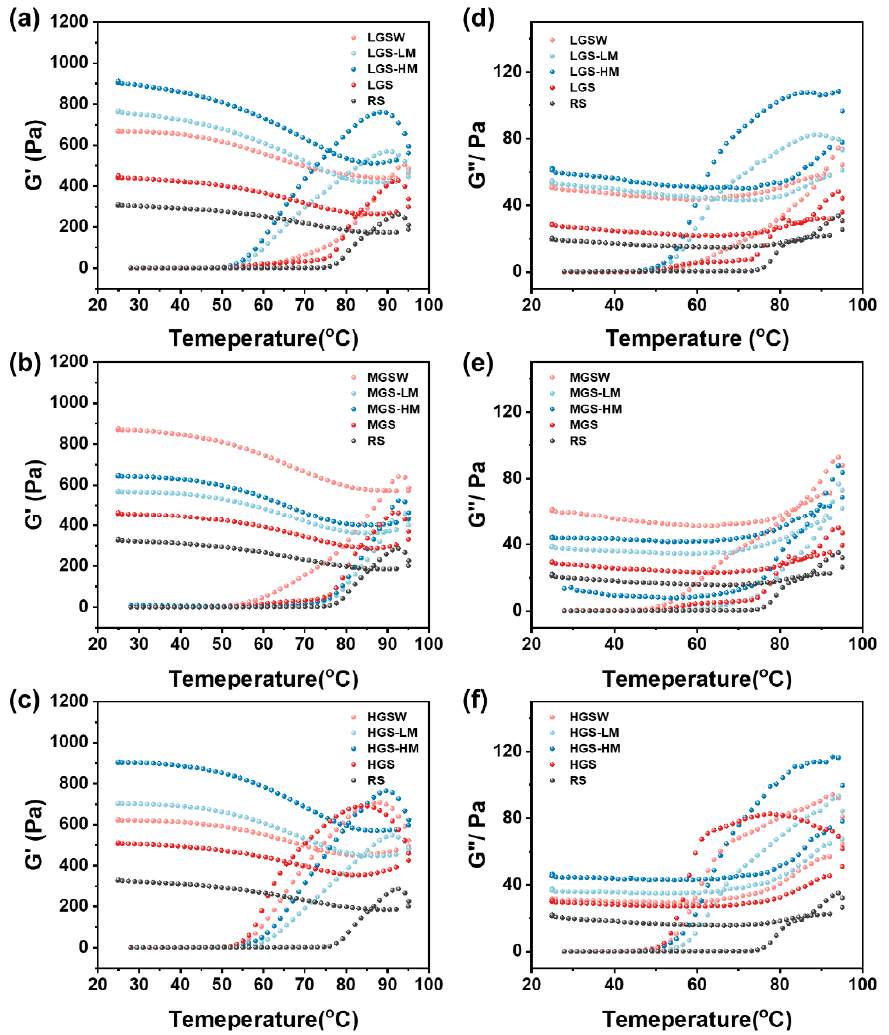
Figure 4. Development of G ′ ( a – c ) and G ″ ( d – f ) of starch pastes reheated by different methods.